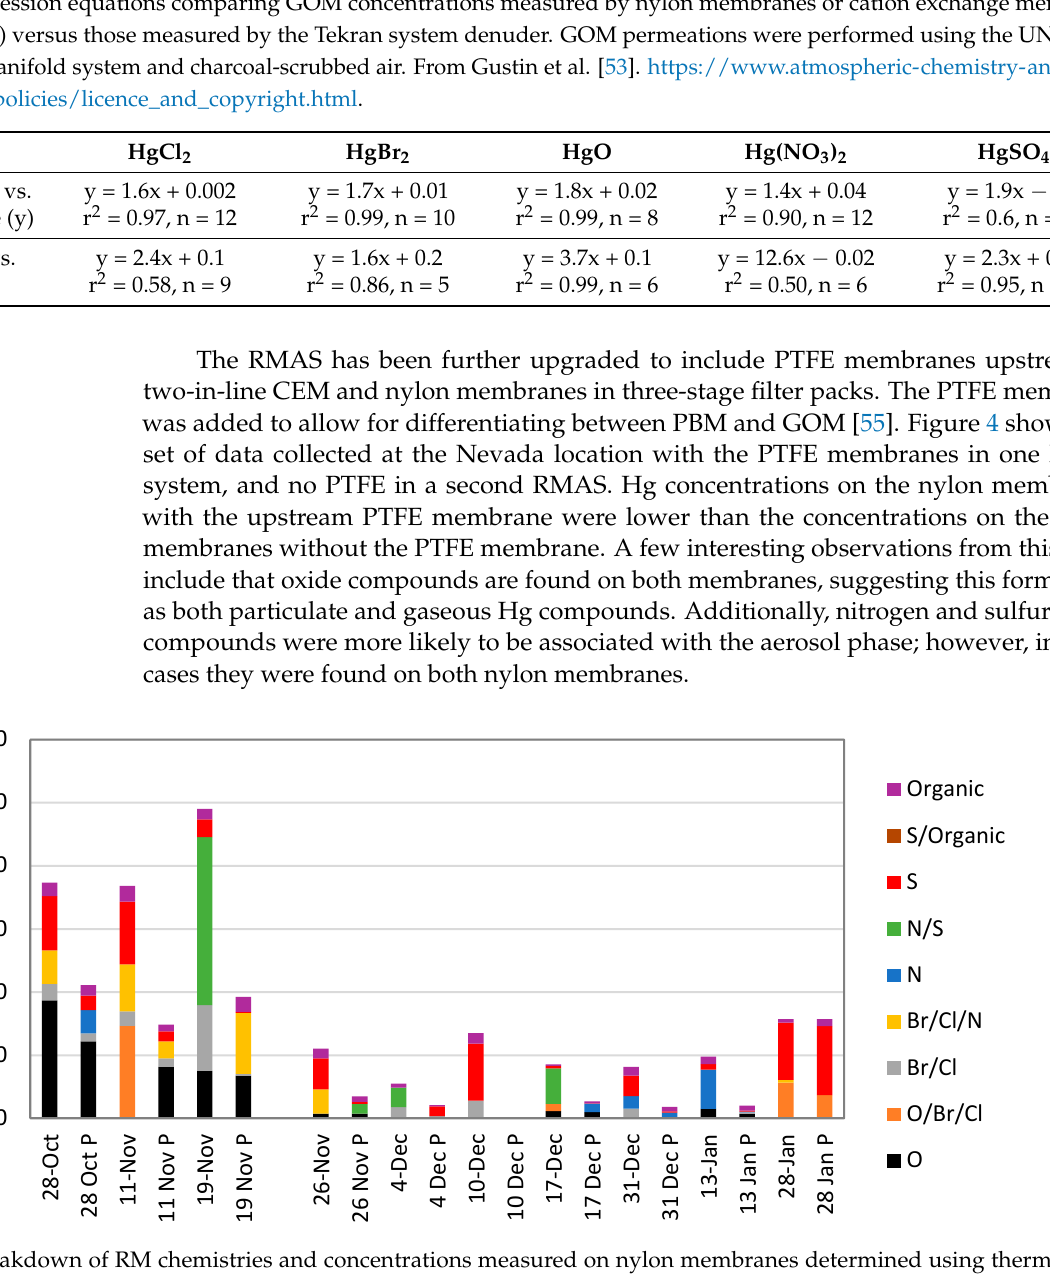
Figure 4. Breakdown of RM chemistries and concentrations measured on nylon membranes determined using thermal desorption and peak deconvolution. There are two sets of data for each sampling period; the date with the “P” is data derived from nylon membranes with an upstream polytetrafluoroethylene (PTFE) membrane. Compounds are designated as the major elements to which Hg(II) is bound based on deconvolution of thermal desorption profiles. Modified from Gustin et al. [53].